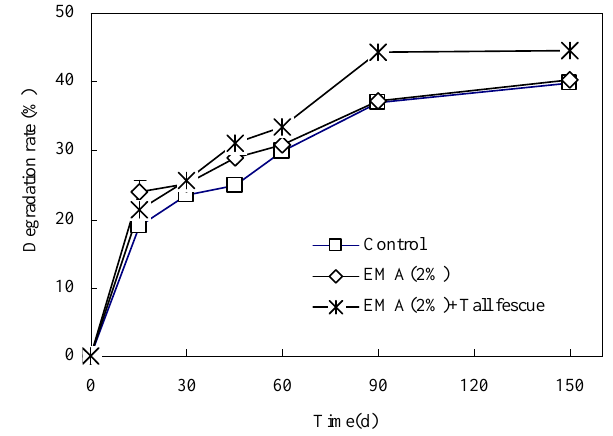
Fig. 6. Degradation of TPH pollutants at different time points dur- ing the rhizoremediation process with tall